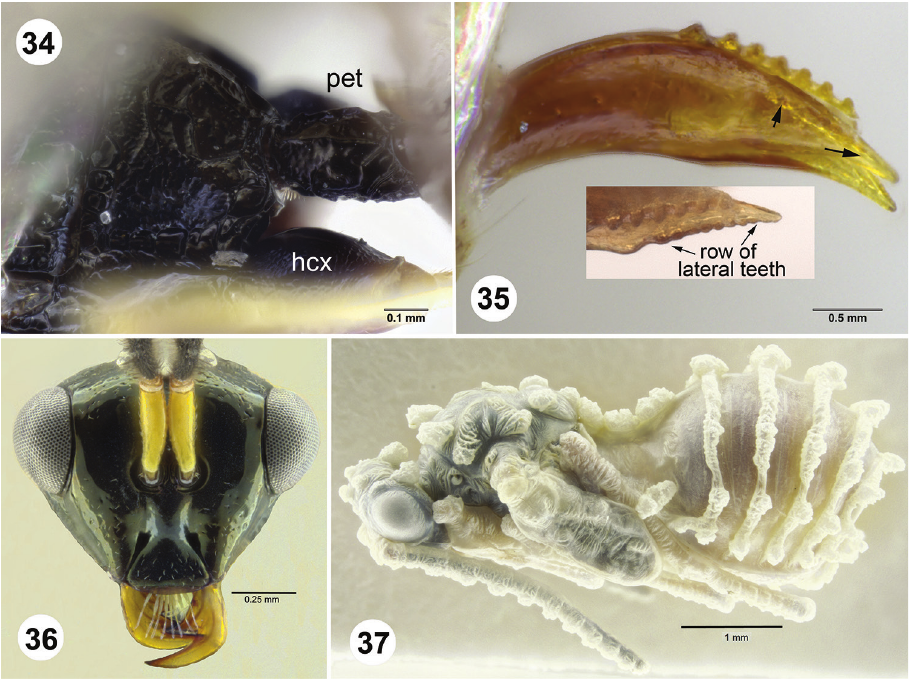
Figures 34–37. 34–35 Hayatosema plicator . Holotype female: 34 propodeum and petiole, dorsal oblique 35 ovipositor, dorsal 36–37 : Ibitya communis. Female: 36 head, frontal 37 pupa. hcx = hind coxa; pet =